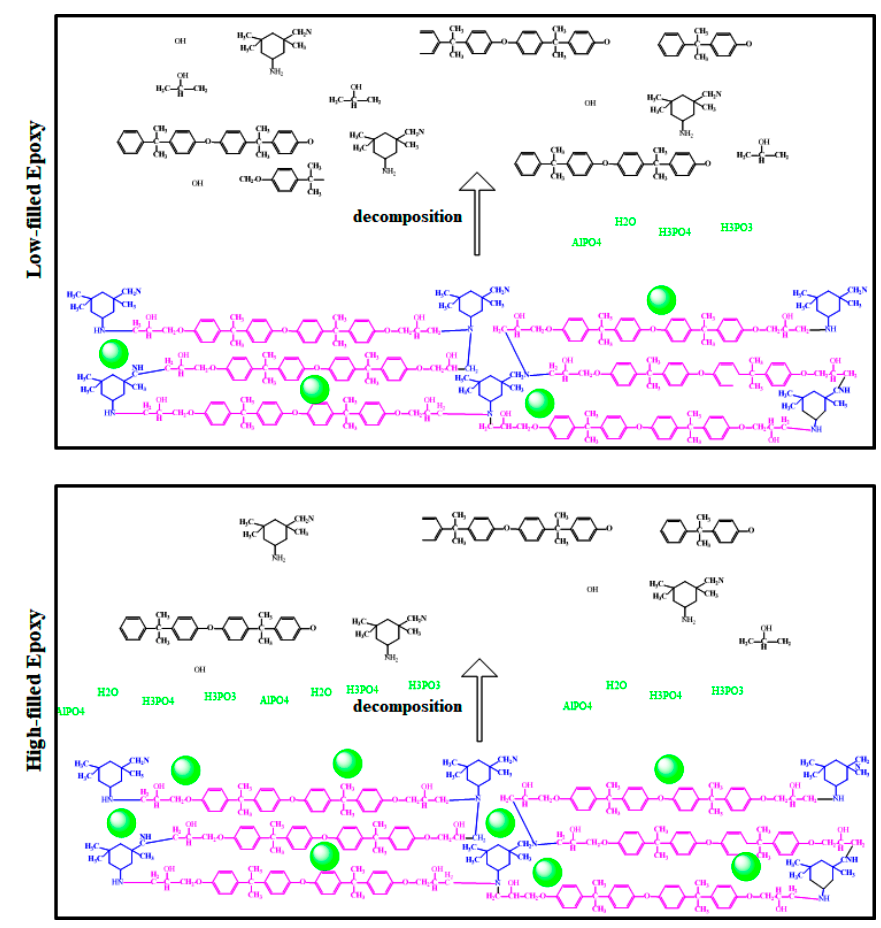
Figure 9. Possible decomposition mechanism of epoxy network in the presence of low (0.1 wt.%) and high (0.5 wt.%) AHP loadings.